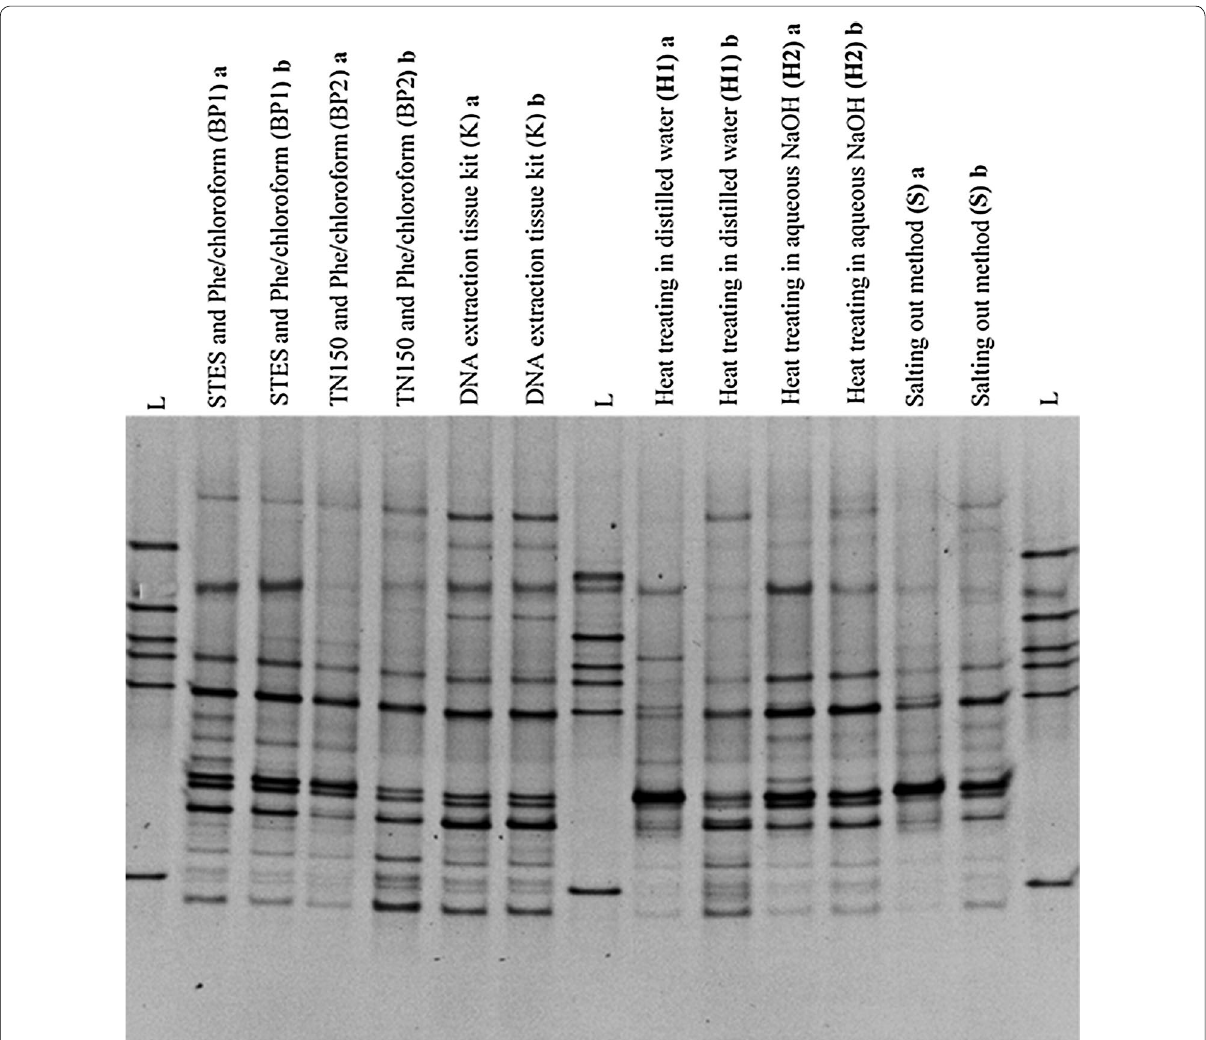
Fig. 3 A comparison of DGGE profiles of PCR amplified bacterial 16S rRNA gene for the specimen No: 1. DNA was extracted using six different DNA extraction methods using 25 mg of wound tissue debridement specimen no. 1. Bacterial fingerprinting profile is based on 30–55% denaturing gradient. “L” lanes represent the in house bacterial reference panel which includes S. aureus, Acinetobacter spp, Group B Streptococcus spp., E. faecalis , Group A Streptococcus spp. and E. coli from top to bottom respectively. Other lanes show bacterial fingerprinting profile of each extraction method in duplicate (a, b) for the specimen No. 1, collected from a subject with a chronic